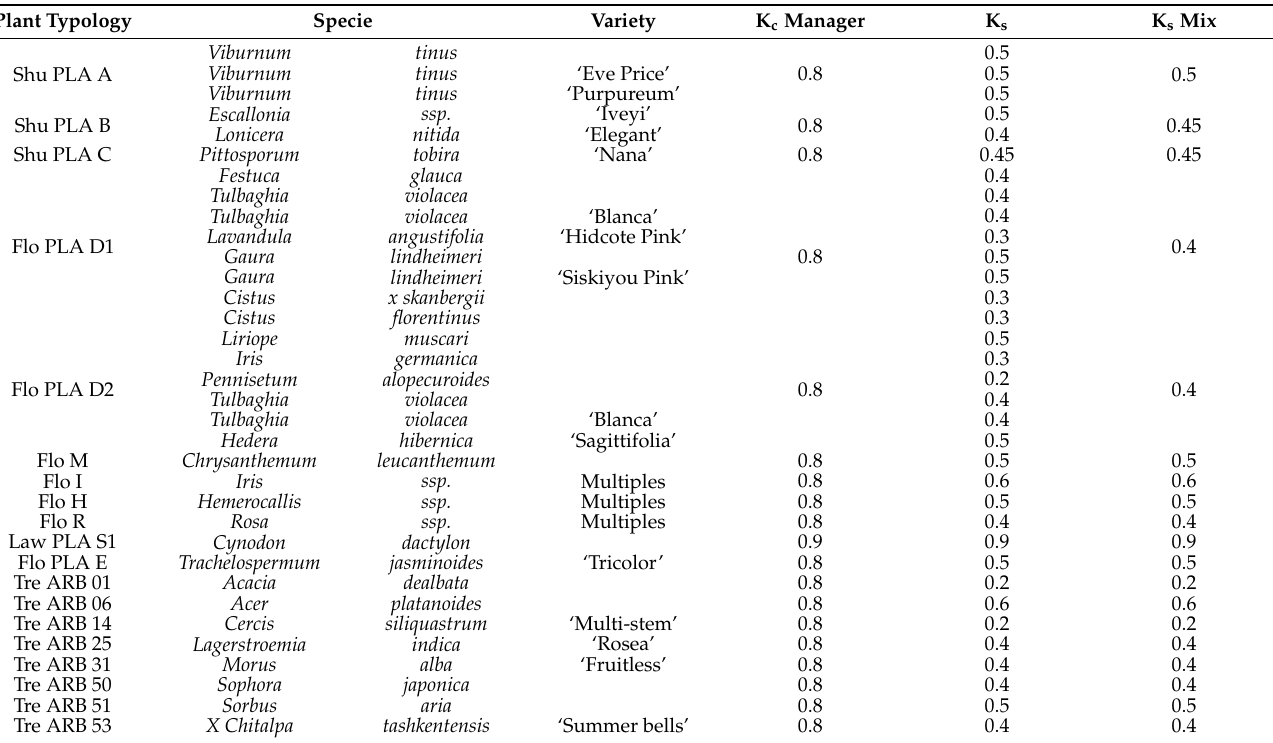
Table 3. Plant typology, plant species, and coefficients for each irrigation